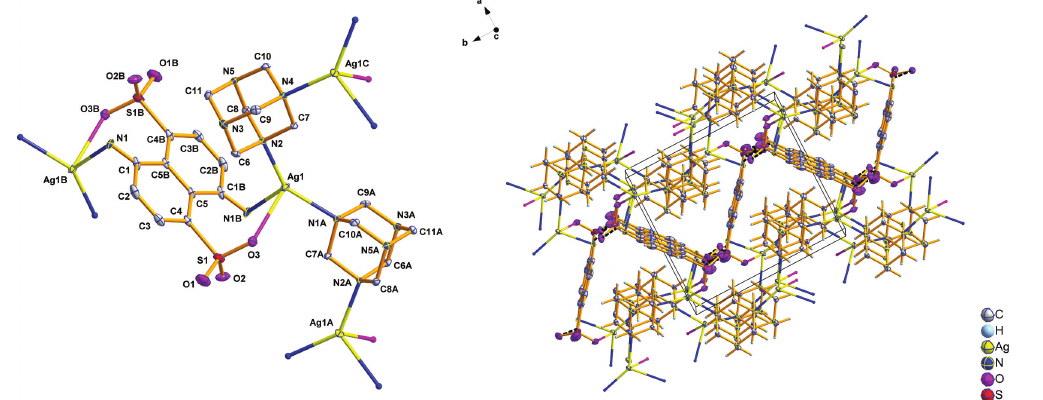
Table 1: Data collection and